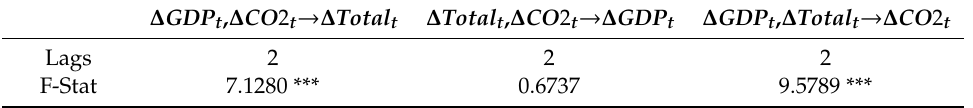
Table 6. Multivariate Linear Granger Causality Test.